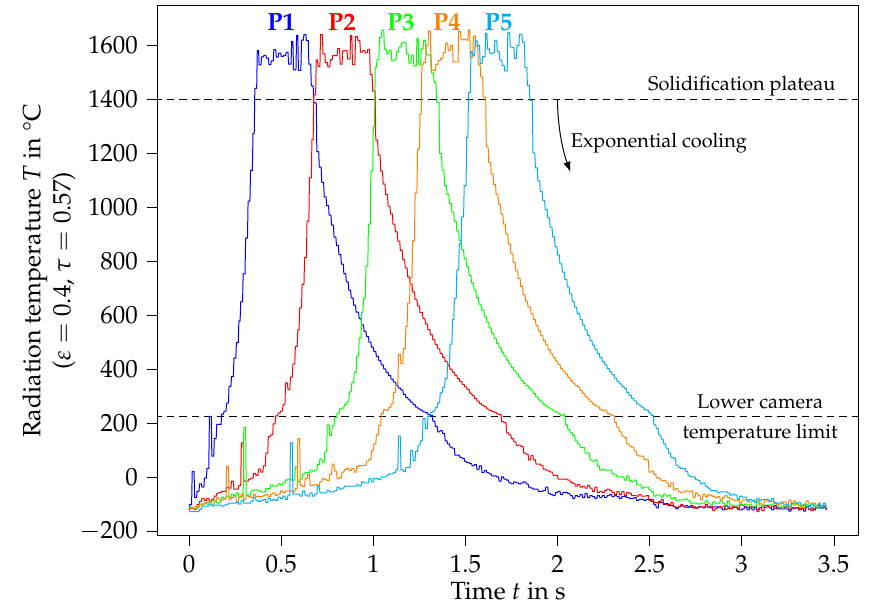
Figure 4. Temperature evolution in five distinct points of the first weld